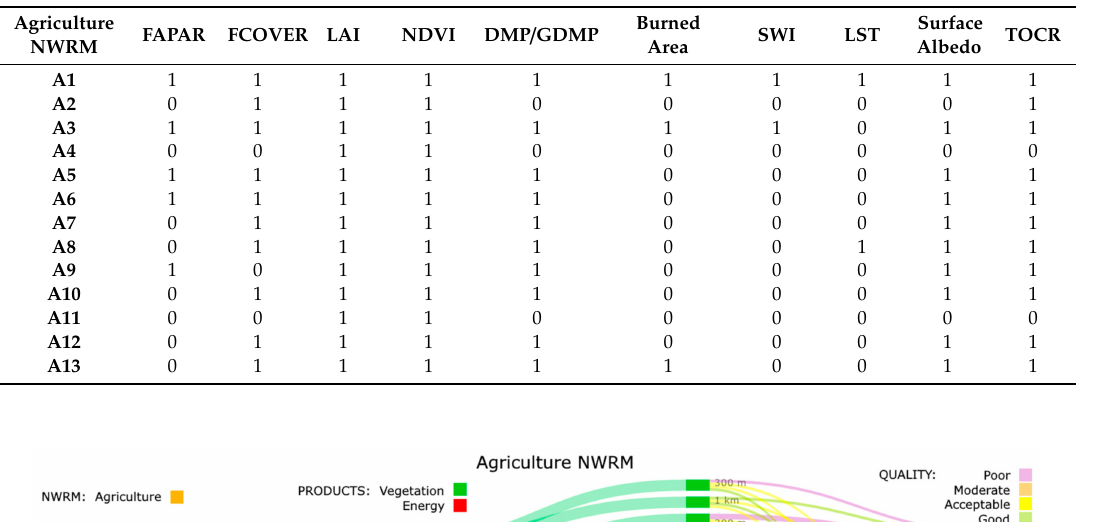
Table 5. Matrix representing the links of the evaluated agriculture NWRM and CGLS. Cell values of 1 or 0 indicate, respectively, whether an article indicating the actual or potential use of a given index to monitor a given agriculture NWRM was found or not during the review of research works.